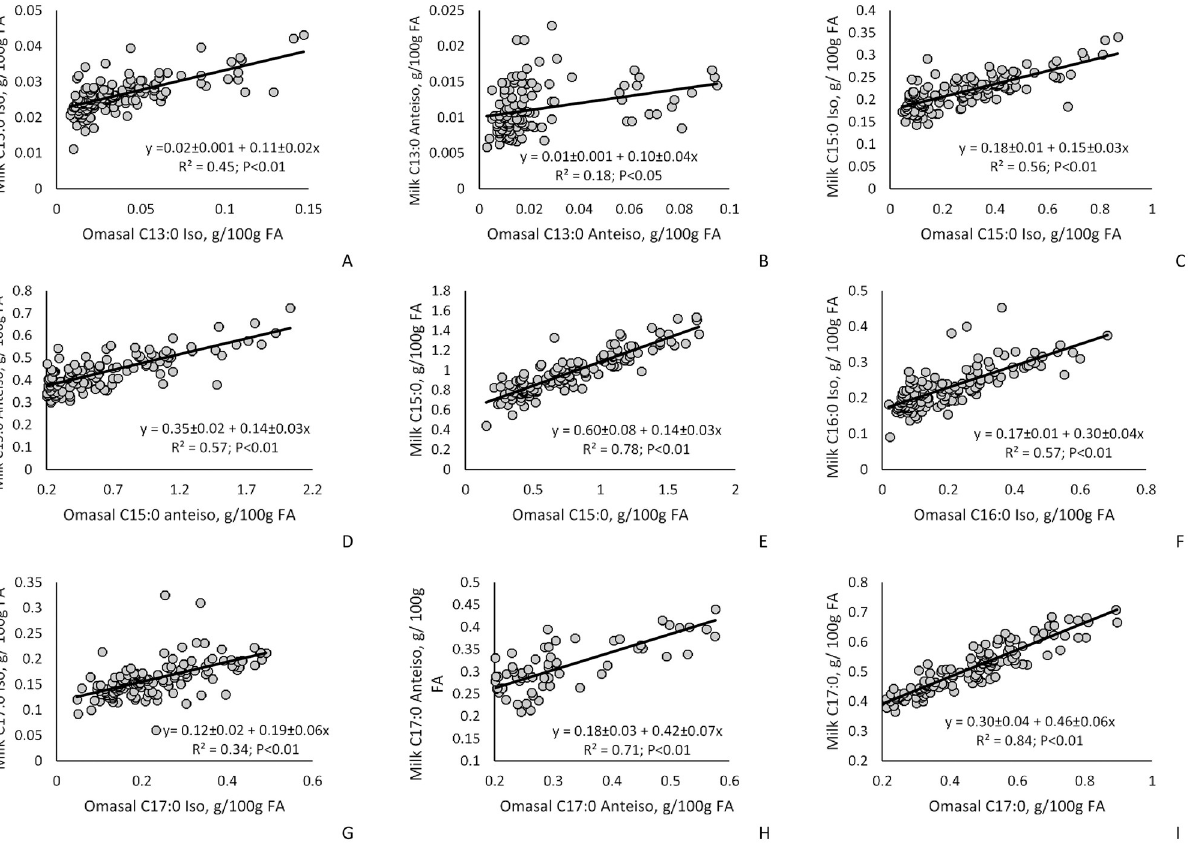
Fig 2. Influence of omasal fatty acid (FA) concentration (g 100 g/ FA) on milk fatty acid concentration (g 100 g/ FA) estimated by univariate mixed model regression analysis (OBCFA = A + BX 1 ) in dairy cows.